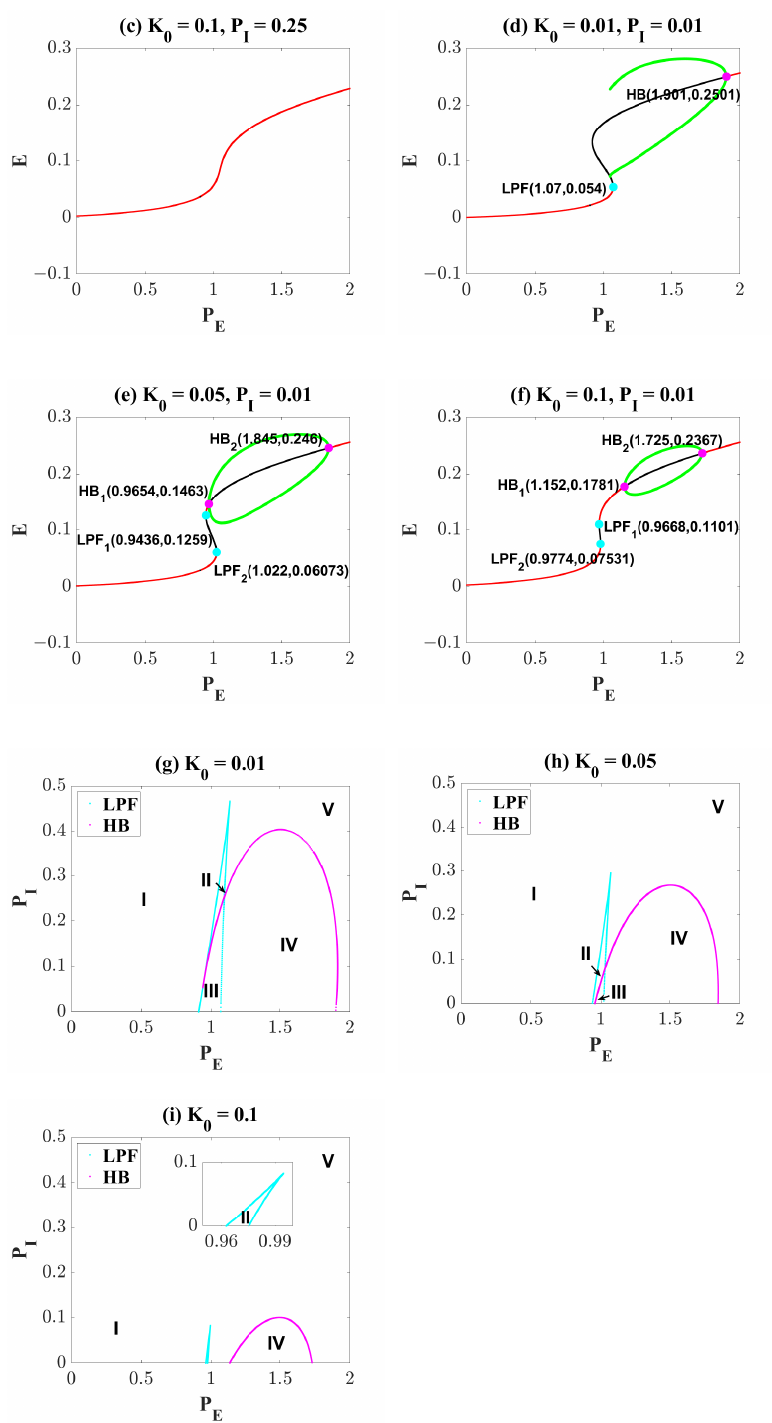
Figure 7. Dynamical bifurcation diagrams induced by P E under the influence of electromagnetic induction ( a – f ). Two-dimensional bifurcation diagrams on the plane ( P E , P I ) under the influence of electromagnetic induction ( g – i ). All symbols have the same meaning as in Figure 1. An increase in K 0 reduces the region of the oscillatory state